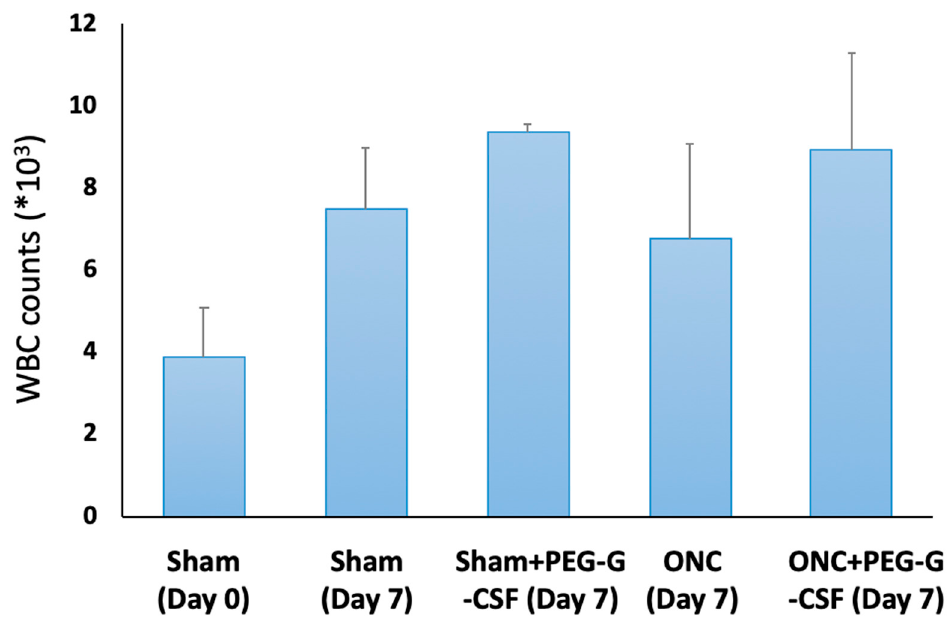
Figure 3. Analysis of white blood cell (WBC) counts in the sham-operated rats with or without intravitreal injection (IVI) of pegylated granulocyte colony-stimulating factor (PEG-G-CSF), and in the optic nerve crushed (ONC) rats with or without IVI of PEG-G-CSF. Though ONC only induced increased WBC counts in peripheral blood, additional IVI of PEG-GCSF did not make a significant difference between the sham-treated group and the ONC group 7 days later.